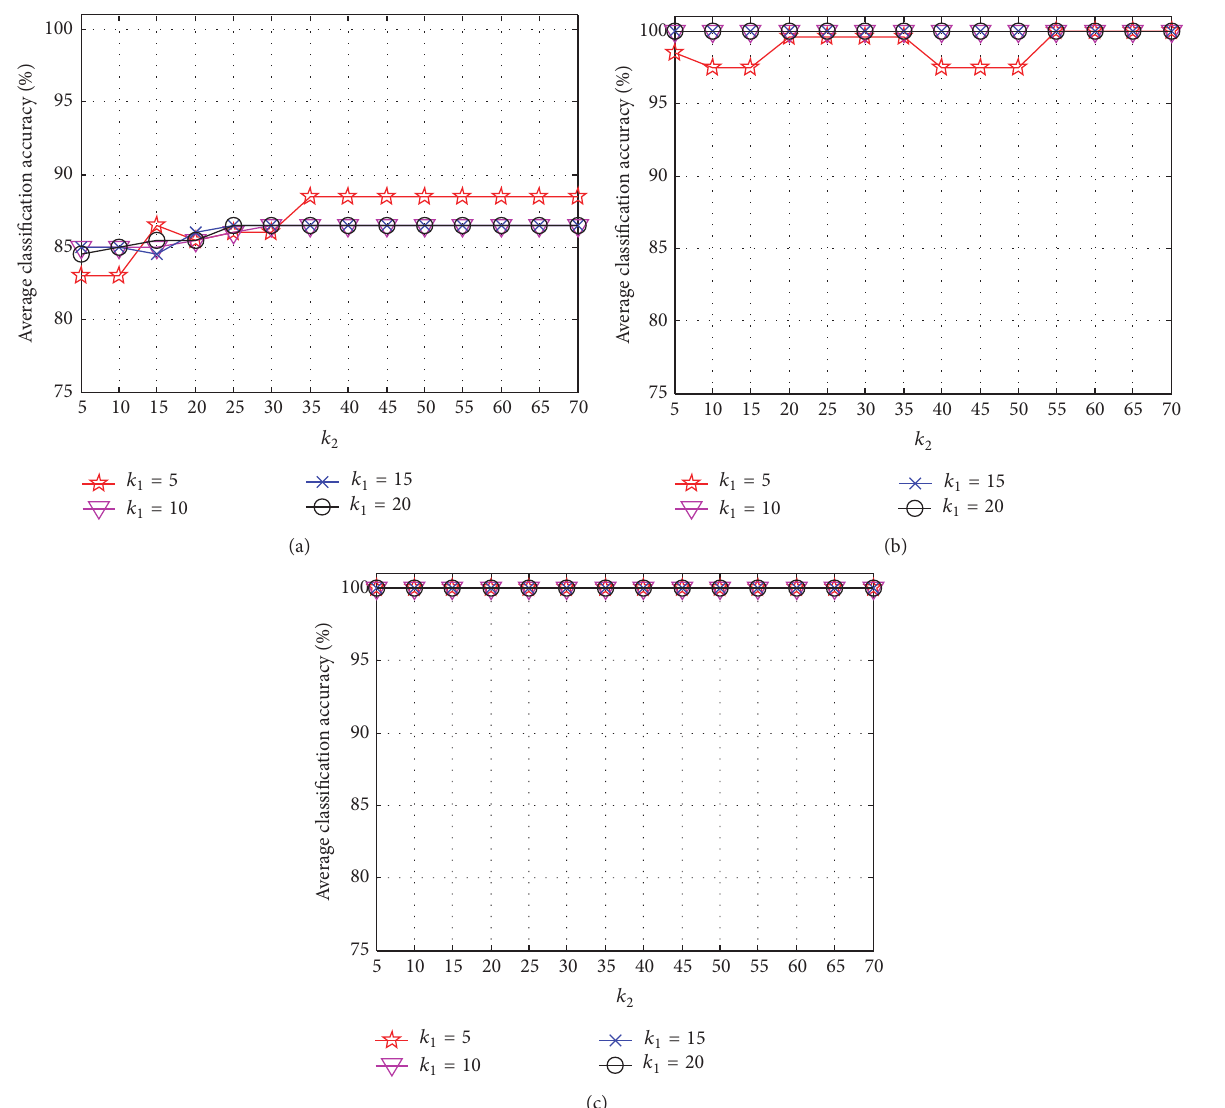
Figure 11: The classification accuracies of (a) KMFA, (b) RKMFA, and (c)